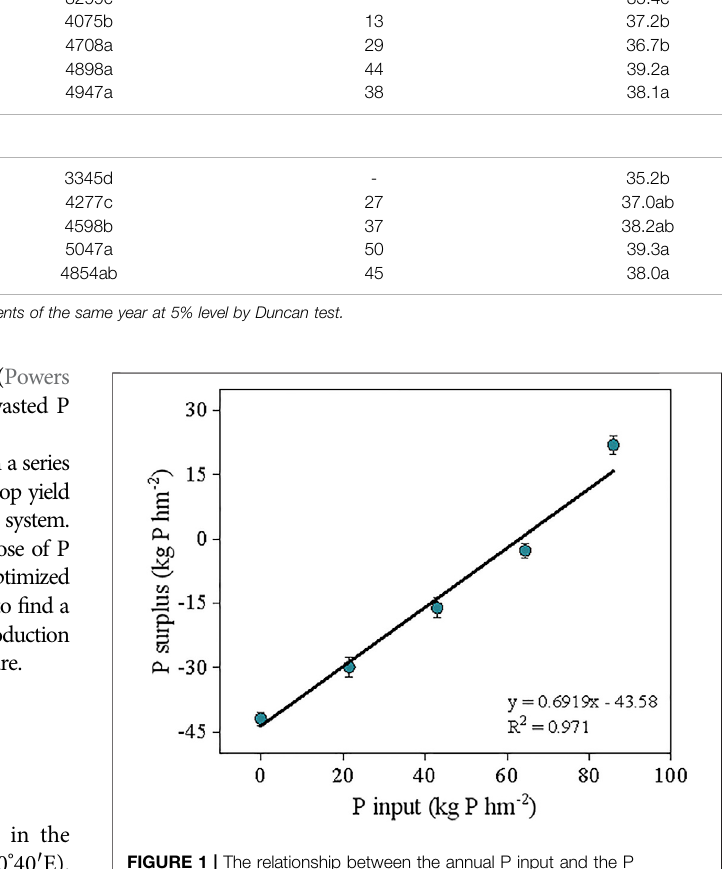
FIGURE 1 | The relationship between the annual P input and the P surplus in rice and wheat rotation according to two years under a series of P fertilization amount